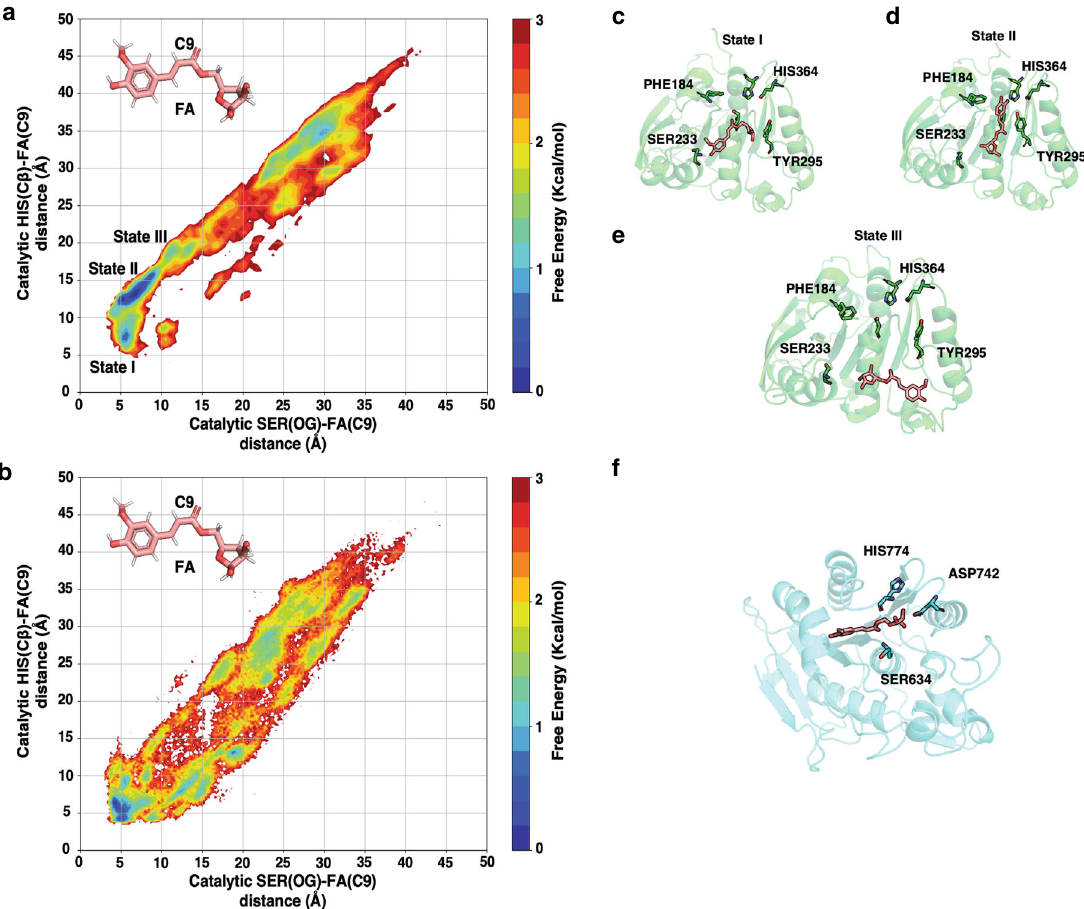
Fig. 8 Accessibility of reaction center of the substrate by catalytic triad. a , b Markov state model (MSM) weighted free energy landscapes are projected as 2-D plots with respect to FA(C9) & HIS (C β ) distance and FA(C9) & SER(OG) distance. c – f Cartoon representation of different stable binding poses of FA substrate close to active site in Bi1039-CE1 ( c , d , e ) and the FAE domain of BeGH43/FAE ( f ). In the stable binding state I ( c ), the aromatic ring of FA binds far away from catalytic HIS364 residue compared to state II ( d ) in Bi1039-CE1. State III ( e ) represents the pose where ligand is entering the